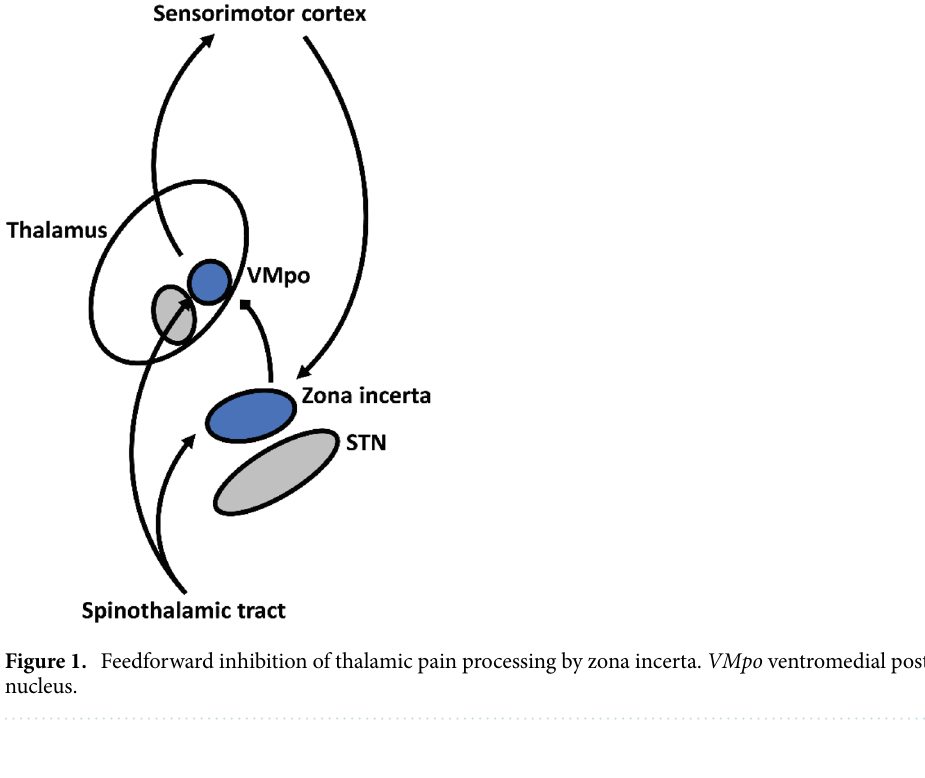
Age Sex GDSS Duration of DBS, months Experiment Data